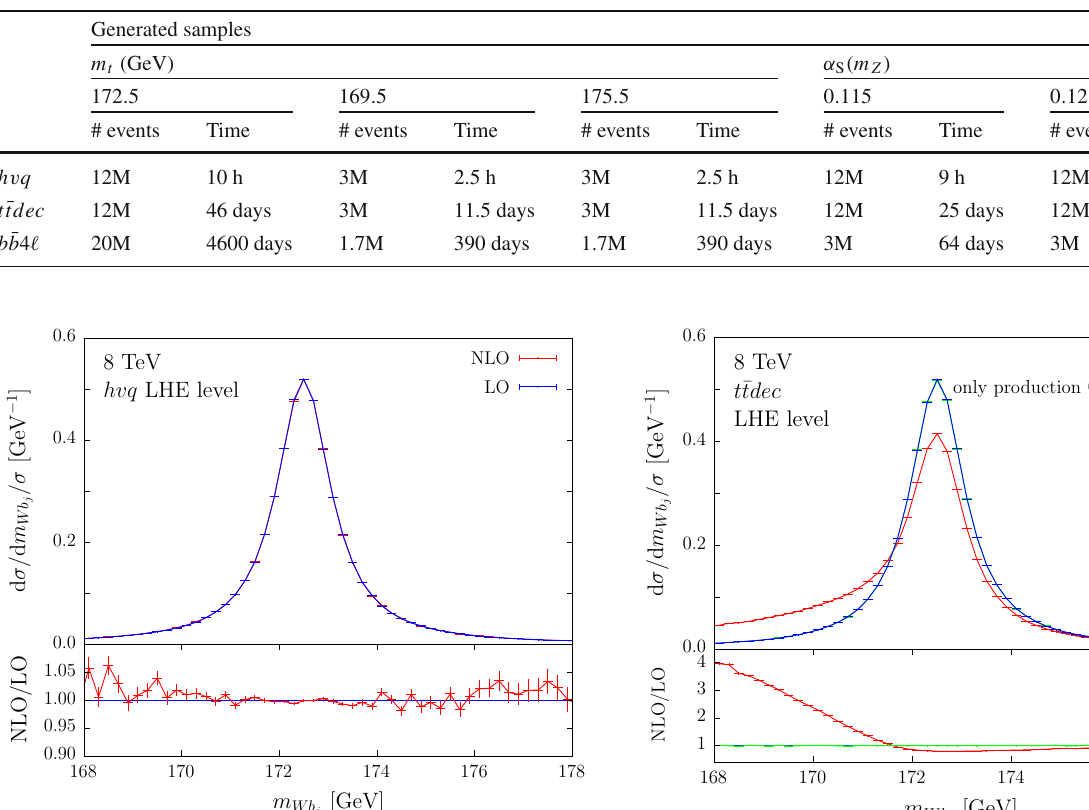
m Wb distributions at LO and NLO are very similar. On the j ¯ b 4 (cid:4) generator (Fig. 2), we other hand, in the case of the b observe large differences below the peak region. These dif- ferences are easily interpreted as due to radiation outside the b -jet cone in the top-decay